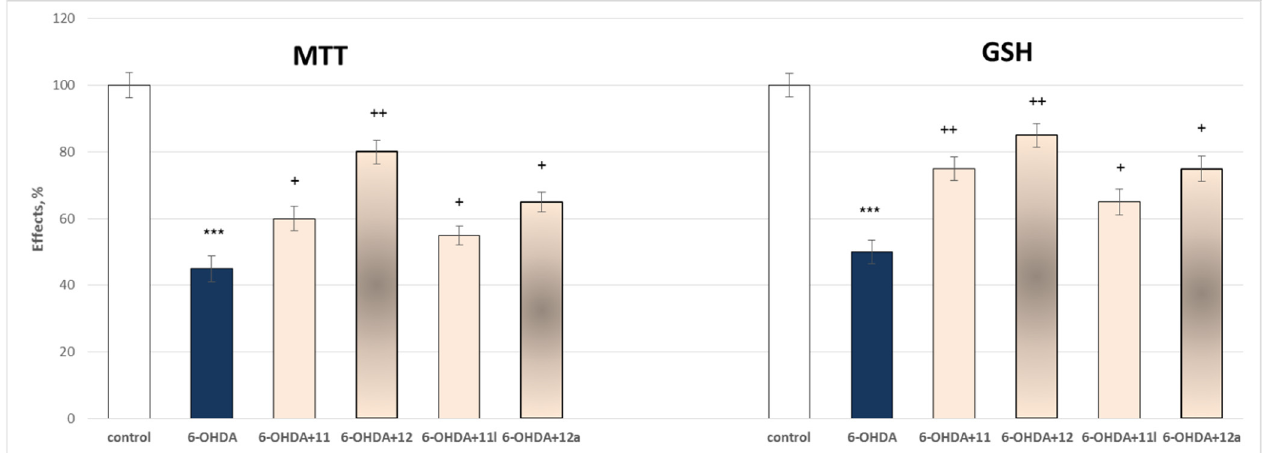
Figure 9. Effects of 11 , 11l , 12 and 12a in a model of 6-OHDA-induced oxidative stress on synaptoso- mal viability. *** p < 0.001 against the control (untreated synaptosomes), + p < 0.05; ++ p < 0.01 against